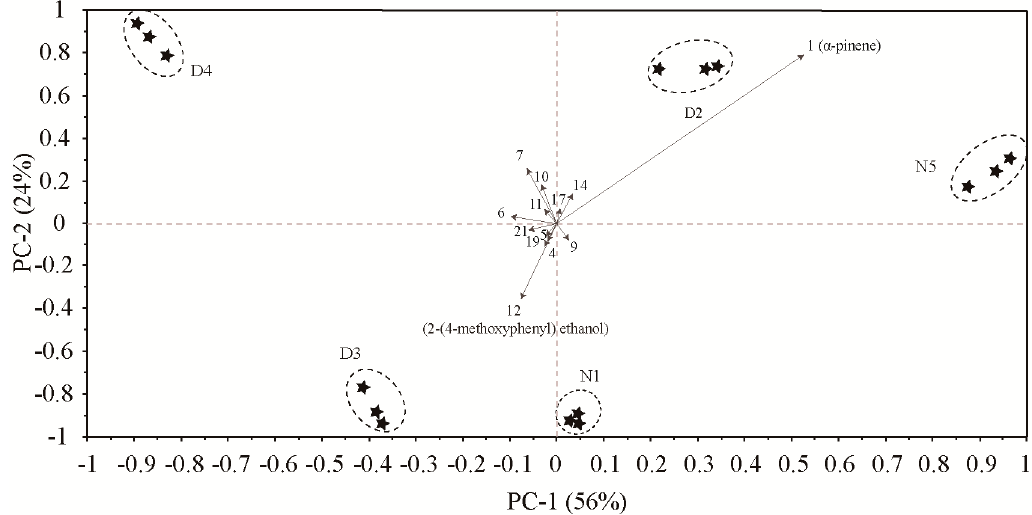
Figure 4. PCA biplot based on the volatile compounds of M . ioensis “Prairie Rose” flowers during the day and night, showing correlations with volatile compounds (numbers correspond to those in Table 1). N1 1:00–3:00, D2 6:00–8:00, D3 10:00–12:00, D4 15:00–17:00 and N5 20:00–22:00.